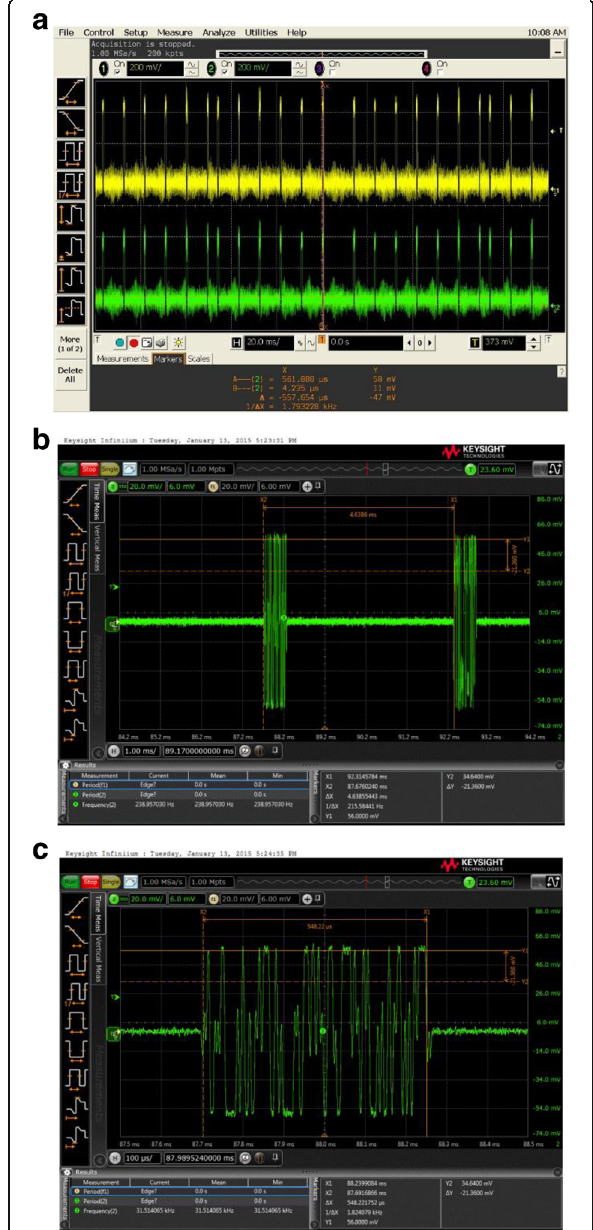
Fig. 1 a : Cellular protocol waveform; ( b ) two adjacent burst pulses; ( c ) intra-pulse